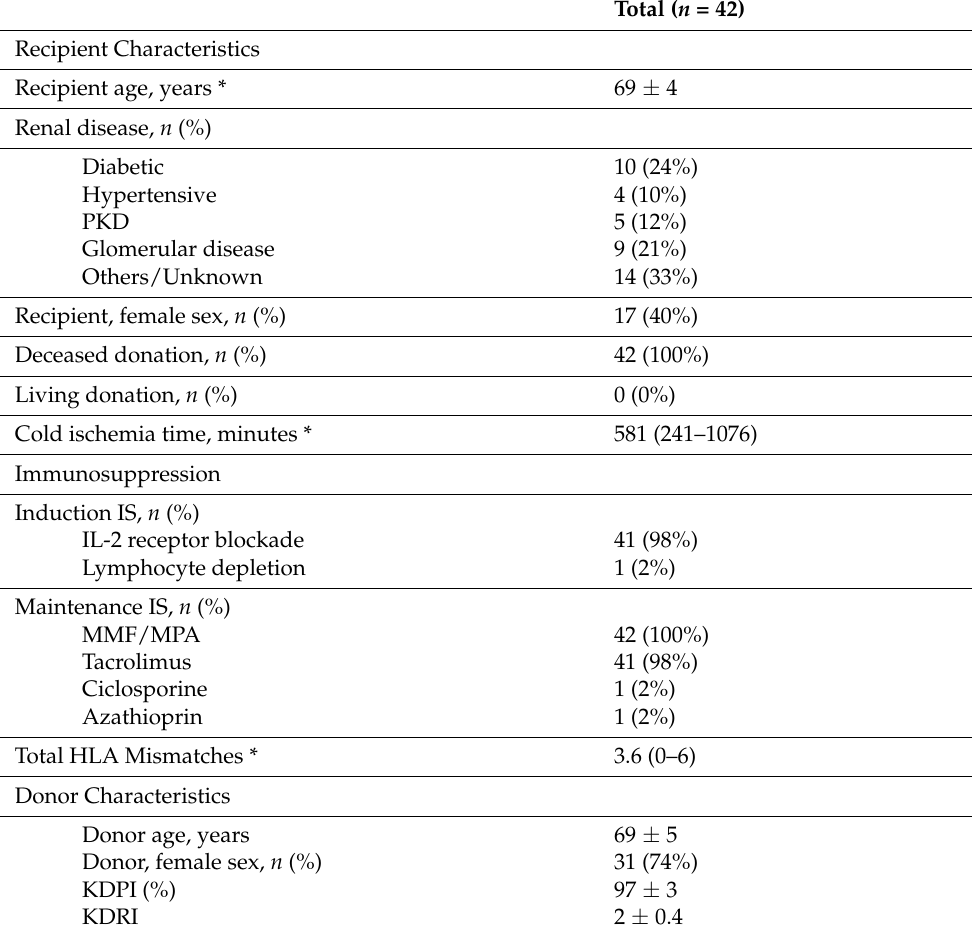
Table 1. Clinical characteristics of kidney transplant recipients. HLA = human leukocyte